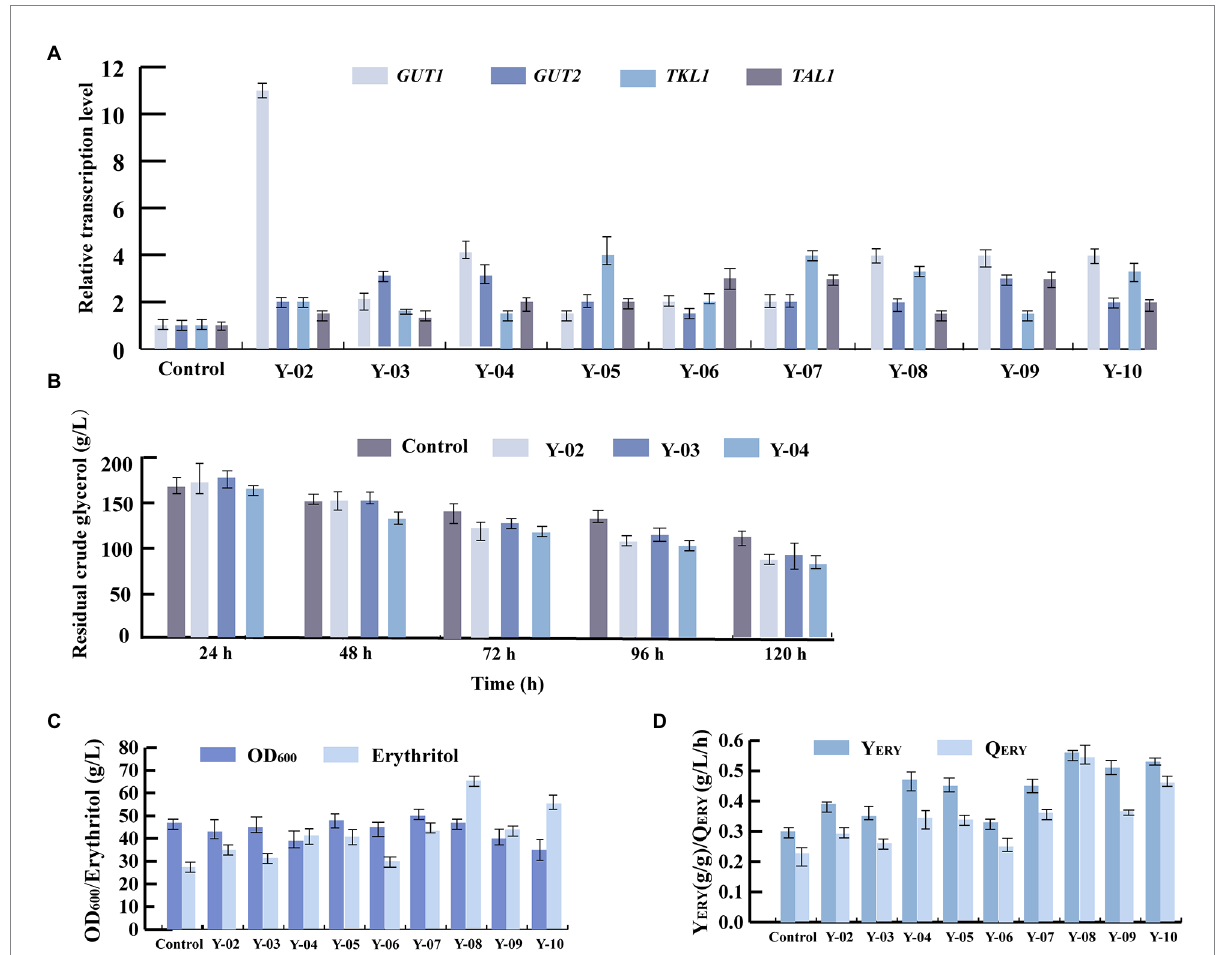
FIGURE 4 Four key genes ( GUT1 , GUT2 , TKL1 , TAL1 ) involved in the synthesis of the erythritol pathway from glycerol were overexpressed individually or in tandem in Y. lipolytica Y01- Δ Ku70 Δ LEU2 . (A) Relative transcription level of GUT1 , GUT2 , TKL1, and TAL1 in different engineered strains. (B) Crude glycerol assimilation in different engineered strains. (C) Erythritol titers and OD 600 in different engineered strains. (D) Erythritol yield and productivity in different engineered strains. Three biological replicates were used to obtain the data. The error bars represented the standard